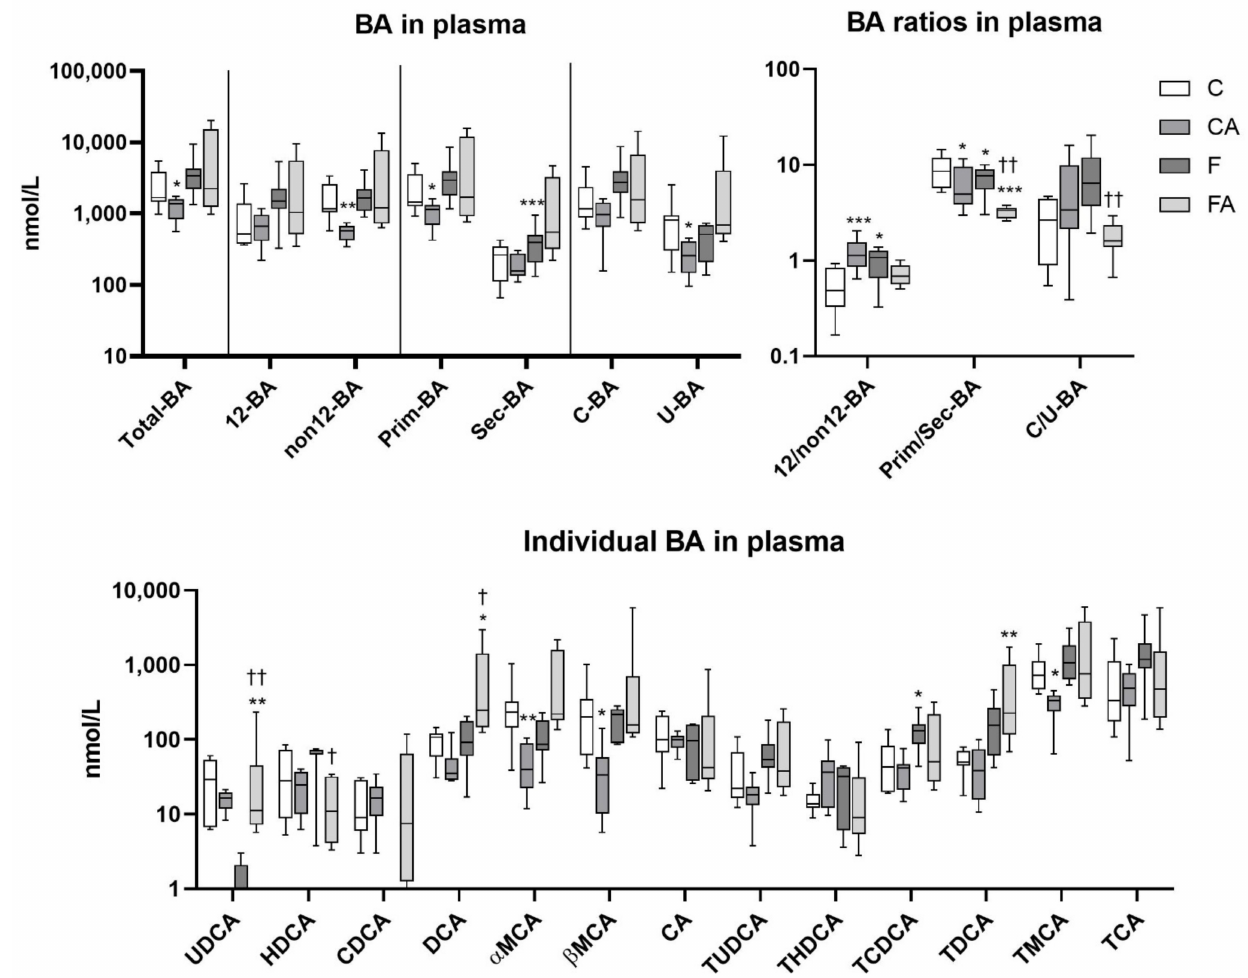
Figure 4. F diet consumption and atorvastatin modulated BA concentrations in plasma. NASH was induced in mice by 24 weeks of F diet consumption, with atorvastatin (A) administered orally (20 mg/kg/day) during the last three weeks. Corresponding control groups received a chow (C) diet. Data are presented as median values, with boxes and whiskers representing the interquartile range and fifth to 95th percentiles, respectively. * p < 0.01, ** p < 0.01, and *** p < 0.001 atorvastatin and/or F-diet vs. vehicle-administered chow diet-treated mice; † p < 0.05 and †† p < 0.01 atorvastatin-treated vs. vehicle-treated NASH mice. BA are presented as follows: 12 α -hydroxylated (12 BA), non12 α -hydroxylated (non12 BA), primary (Prim-BA), secondary (Sec-BA), conjugated (C-BA), unconjugated (U-BA), ursodeoxycholic acid (UDCA), hyodeoxycholic acid (HDCA), chenodeoxycholic acid (CDCA), deoxycholic acid (DCA), α / β muricholic acid ( α / β MCA), and cholic acid (CA), with taurine conjugates TUDCA, THDCA, TDCA, TMCA, and